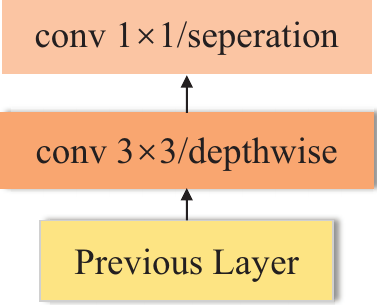
Figure 10. The architecture of depthwise separable convolution.